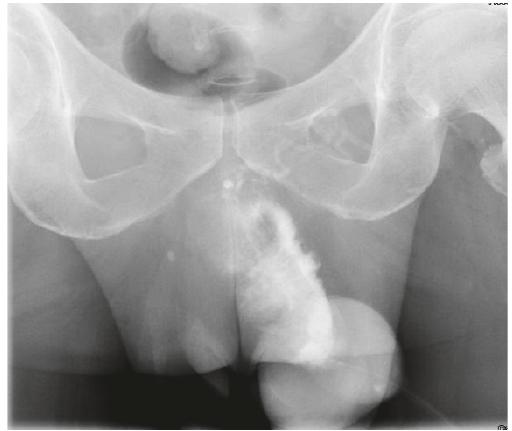
Figure 1: Retrograde urethrogram showed significant extravasation of contrast from anterior penile urethra to surrounding soft tissue.